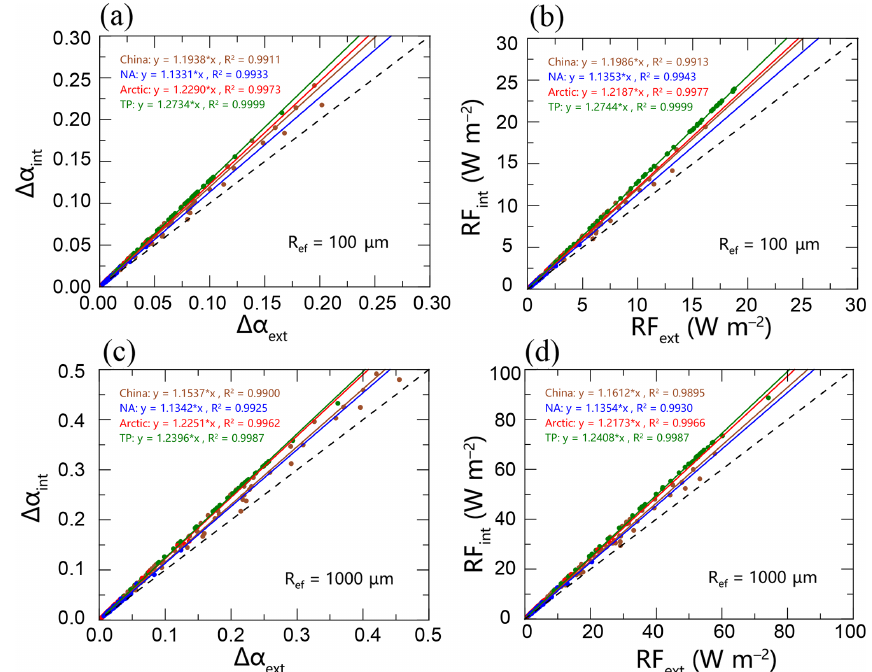
Figure 11. Comparisons of (a) snow albedo reduction and (b) radiative forcing via internally mixed particles versus externally mixed particles based on in situ measurements of fresh snow (assuming a snow grain radius of 100µm). Panels (c) and (d) are the same as (a) and (b) , respectively, but for old snow and assuming a snow grain radius of 1000